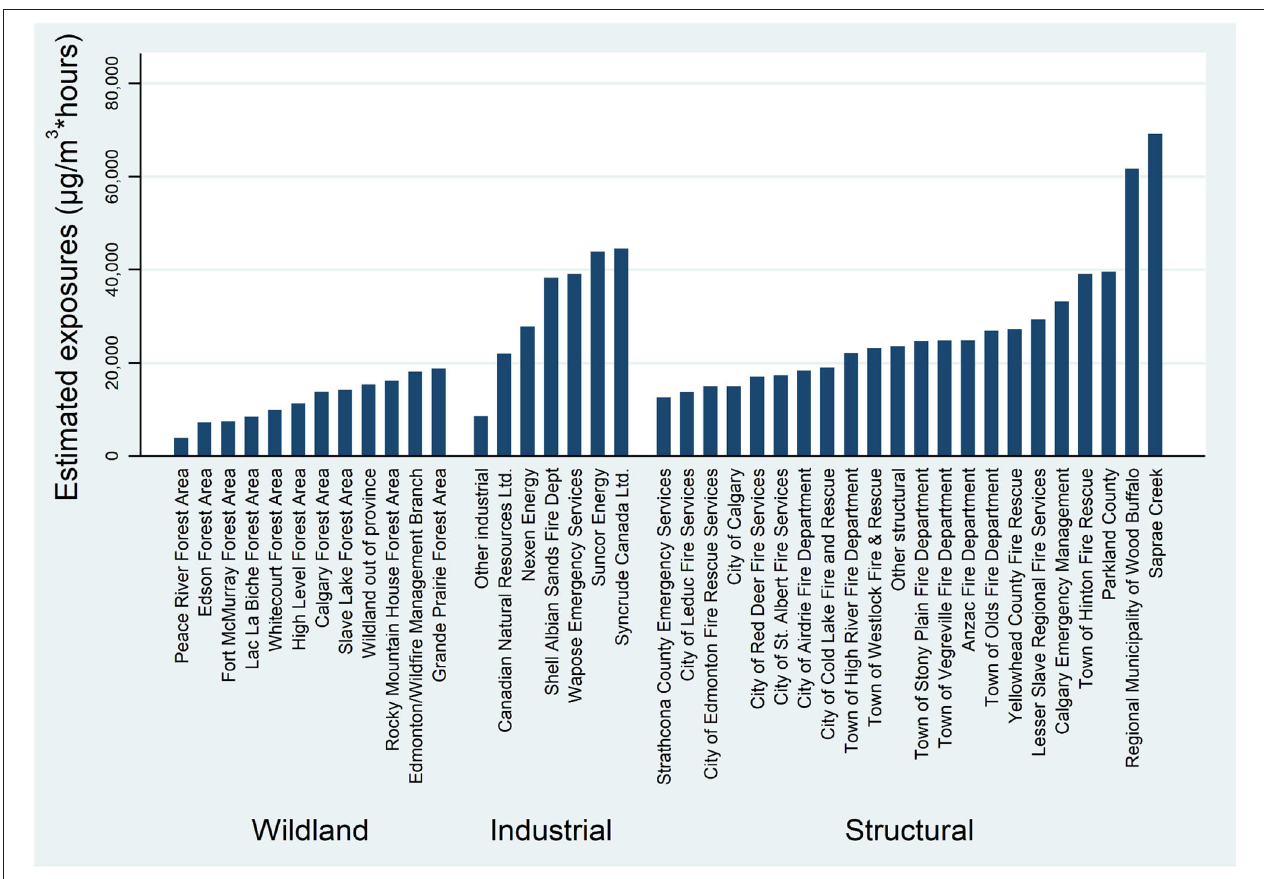
FIGURE 2 | Estimated exposure to PM 2.5 in firsif00t rotation by fire service and grouped by type of service.